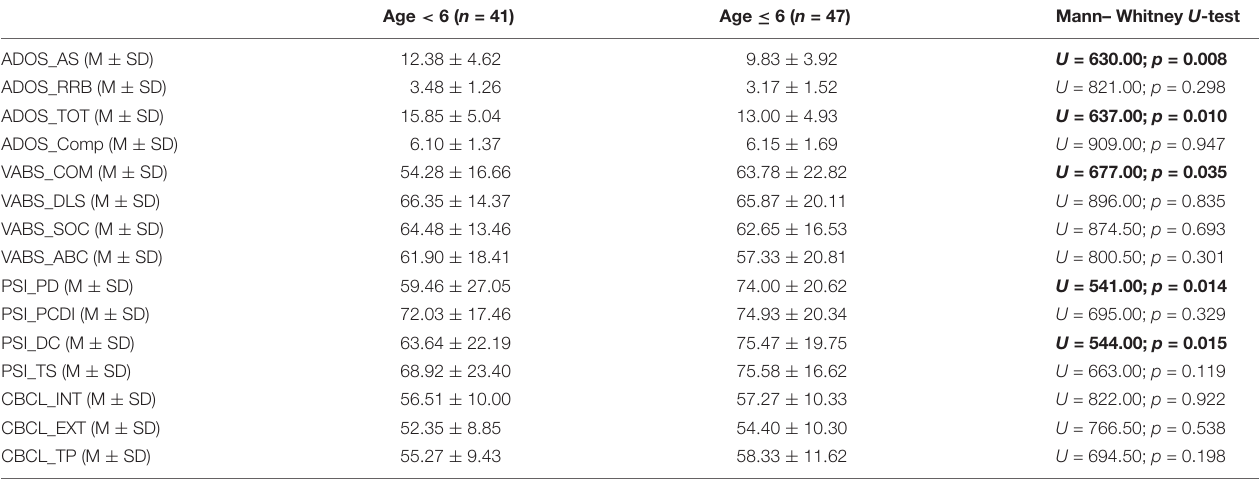
TABLE 4 | Mean scores comparison between Age